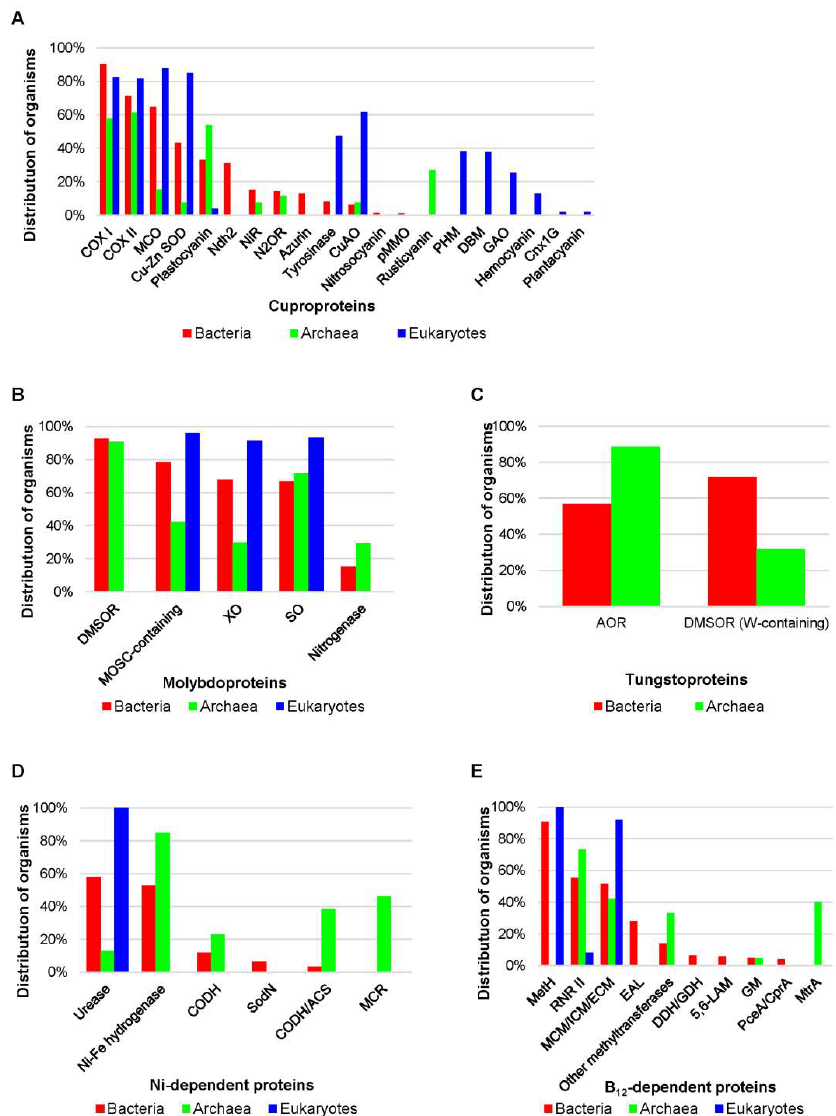
Figure 2. Distribution of metalloprotein families in the three domains of life. ( A ) Distribution of cuproproteins in Cu-utilizing organisms; ( B ) Distribution of molybdoproteins in Mo-utilizing organisms; ( C ) Distribution of tungstoproteins in W-utilizing organisms; ( D ) Distribution of Ni-dependent proteins in Ni-utilizing organisms; ( E ) Distribution of B 12 -dependent proteins in Co-utilizing organisms. COX I, cytochrome c oxidase subunit I; COX II, cytochrome c oxidase subunit II; MCO, multicopper oxidase; Cu-Zn SOD, Cu-Zn superoxide dismutase; Ndh2, NADH dehydrogenase 2; NiR, nitrite reductase; N2OR, nitrous oxide reductase; CuAO, Cu amine oxidase; pMMO, particulate methane monooxygenase; PHM, peptidylglycine α -hydroxylating monooxygenase; DBM, dopamine β -monooxygenase; GAO, galactose oxidase; DMSOR, dimethylsulfoxide reductase; XO, xanthine oxidase; SO, sulfite oxidase; AOR, aldehyde:ferredoxin oxidoreductase; CODH, carbon monoxide dehydrogenase; SodN, Ni-containing superoxide dismutase; CODH / ACS, acetyl-coenzyme A synthase / decarbonylase; MCR, methyl-coenzyme M reductase; MetH, methionine synthase; RNR II, B 12 -dependent ribonucleotide reductase class II; MCM, methylmalonyl-CoA mutase; ICM, isobutyryl-CoA mutase; ECM, ethylmalonyl-CoA mutase; EAL, ethanolamine ammonia lyase; DDH / GDH, diol / glycerol dehydratase; 5,6-LAM, D-lysine 5,6-aminomutase; GM, glutamate mutase; PceA / CprA, B 12 -dependent reductive dehalogenase; MtrA, methyltetrahydromethanopterin:coenzyme M methyltransferase subunit A. Data used to generate this figure are available in the supplementary information of [81] and [83].